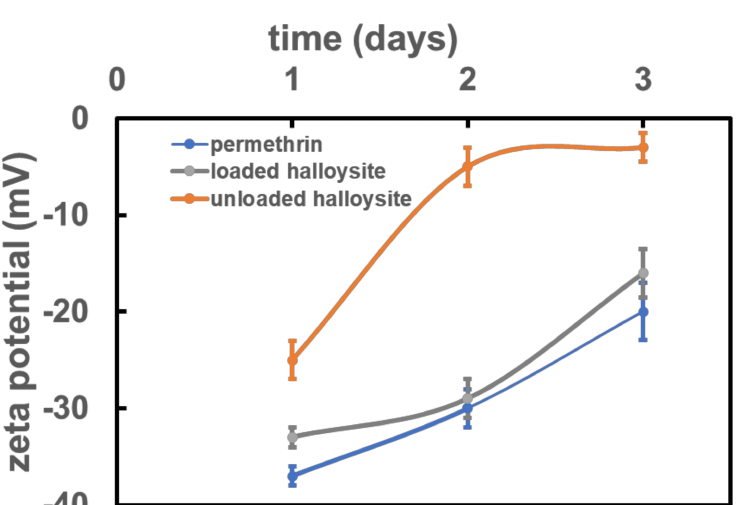
Figure 7. Zeta potentials of permethrin unloaded (pristine), and permethrin-loaded halloysites in water at pH